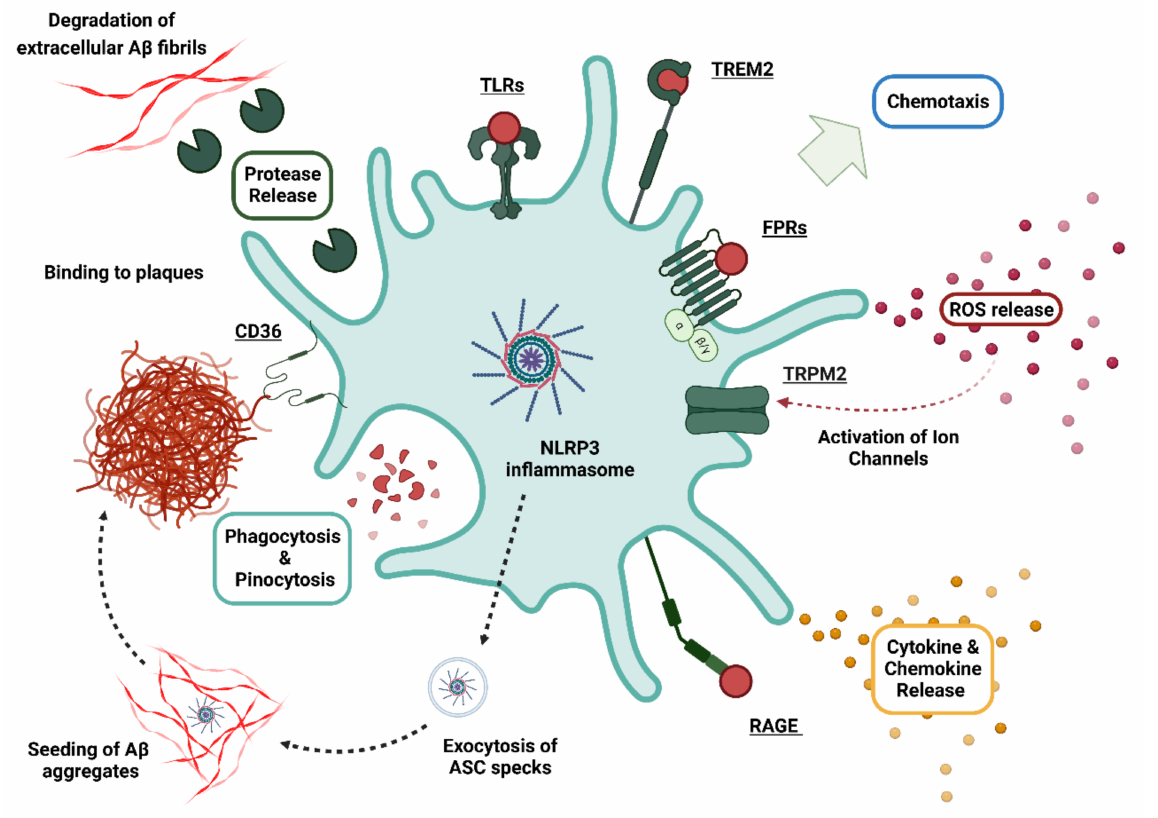
Figure 4. Cellular responses of microglia after detection of A β . Microglia are capable of perceiving soluble A β peptides and insoluble aggregates via multiple cell-surface receptors, which then induce varied cellular responses such induction of cell migration, cytokine and chemokine release, secretion of proteases, and generation of oxidative stress [3,23]. These processes are in part regulated by the intracellular NLRP3 inflammasome. The release of inflammasome components (ASC specks) may lead to seeding of A β and may thus contribute to plaque formation